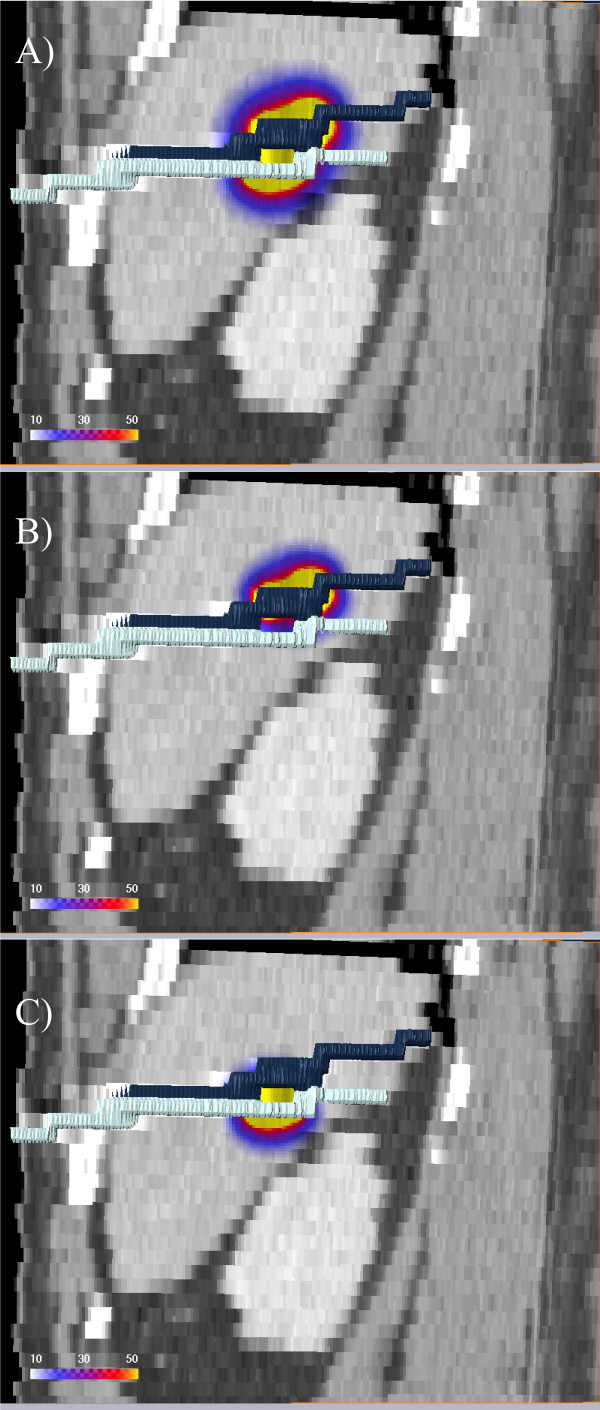
Dose separation. The 3D visualization shows a coronal CT reconstruction with the calculated dose in Gy overlayed using the patient in Fig. 1. The dose is applied using two catheters. The two catheters were visualized in 3D using surface rendering of the catheters labeled in the CT scan. A) Total dose, Dtot , overlayed. B) Dose applied by the cranial catheter, D1. C) Dose applied by the caudal catheter, D2 .